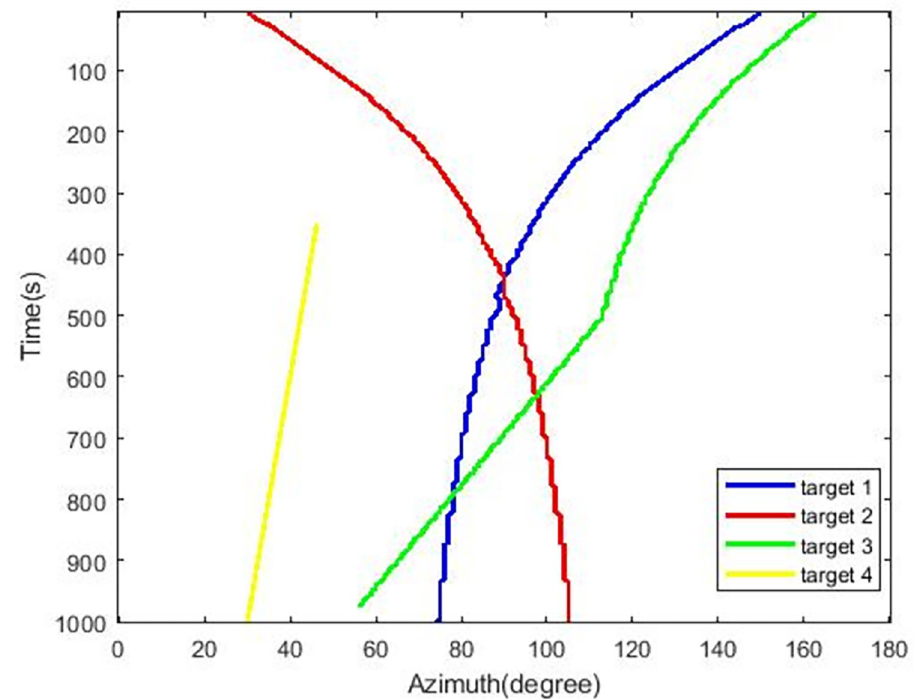
Fig 10. Simulated target azimuth over time.